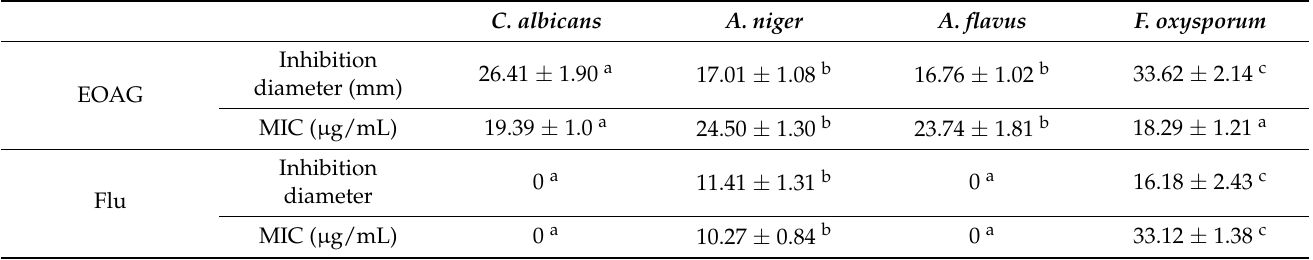
(Table 3). Remarkably, the largest inhibition zone diameters were recorded in F. oxysporum, with a calculated value of 33.62 ± 2.14 mm, followed by C. albicans, with a noticed value of 26.41 ± 1.90 mm. The results noted the antifungal resistance of C. albicans and A. flavus to fluconazole, which was used as a drug reference (Table 3). Similarly, the MIC results showed that EOAG strongly inhibited the fungal pathogenic strains used for testing, recording MICs values ranging from 18.29 ± 1.21 to 24.50 ± 1.30 µ g/mL (Table 3). Table 3. Antifungal power of EOAG as assessed by use of inhibition zone diameters and MIC